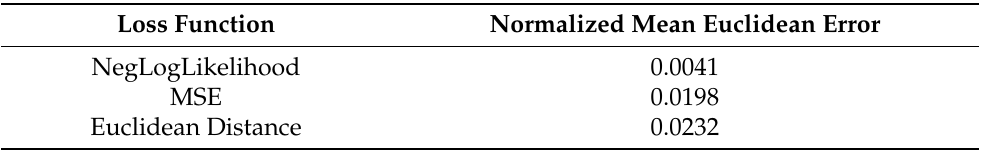
Table 3. Loss function comparison. Holdout set was help constant as AO15. Error is the average distance error over the entire holdout set in normalized distances.